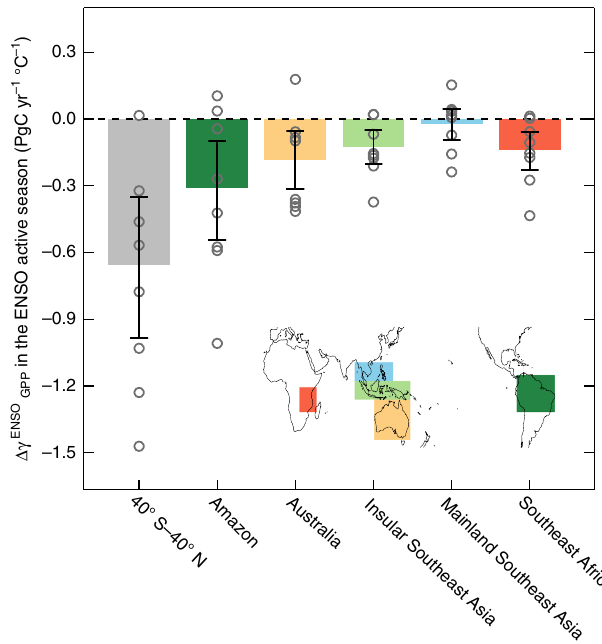
Fig. 3 Regional contributions of enhanced gross primary production response to ENSO. Differences in the regression coef fi cients of regional gross primary production anomalies from September to February for the December – February Nin ̃ o3.4 index between the preindustrial experiment and ECP4.5. Each bar shows the results of the multimodel ensemble based on each region as marked on the map. Open circles denote the individual results of the ESM. Error bars indicate 95% con fi dence levels calculated using the bootstrap